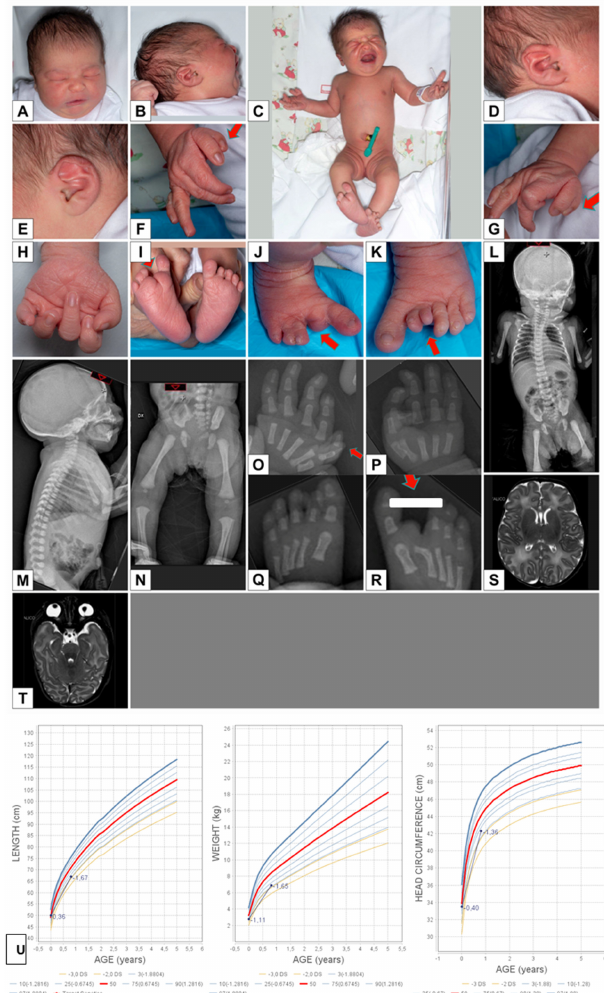
Figure 2. ( A – E ) Clinical examination at birth: normal head, severe bilateral microphthalmia. ( F – H ) Preaxial polydactyly on the right hand. ( I – K ) Right split foot with four toes and third–fourth syndactyly and on the left foot: second toe polydactyly with nail. ( L – N ) Skeletal x-ray: no vertebral anomalies, no long bone anomalies. ( O – R ) Right hand x-ray: preaxial polydactyly with one metacarpal and two proximal and distal phalanges; right foot x-ray: split foot with four toes and five metatarsals: curved second metatarsal; left foot x-ray: second toe polydactyly. ( S , T ) Brain MRI: Bilateral enophthalmos with markedly dysmorphic appearance of the eyeballs with profile irregularities in particular on the posterior part in correspondence with the head region of the optic nerve and bilateral coloboma. On the left, dysmorphic appearance and posterior displacement of the lens, anchored to the ciliary body/suspensory ligaments that appear stretched with secondary enlargement of the anterior chamber; on the posterior side the lens appears deformed and attracted posteriorly in relation to the persistence of the hyaloid canal (persistent hyperplastic primary vitreous body, PHPV). More nuanced and slender PHPV finding is also evident in the right eyeball where the posterior surface of the lens appears slightly dysmorphic. The optic nerves (with a slightly tortuous course in the retrobulbar tract) are appreciable bilaterally, the chiasm and the optic tracts are also regularly displayed. ( U ) Somatometric data at birth and at 10 months of